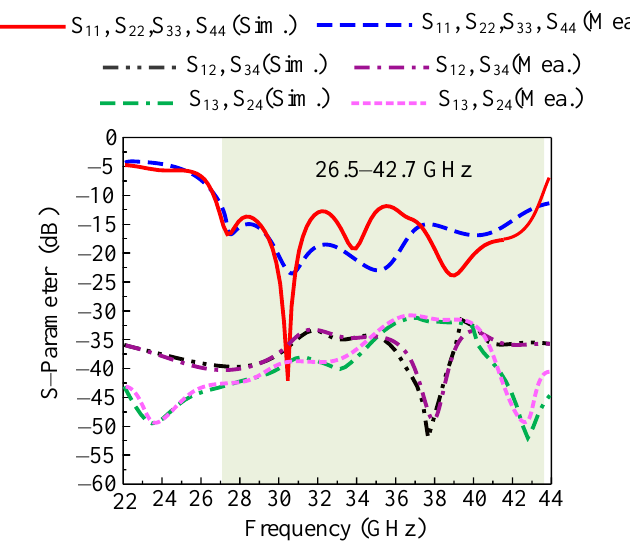
Figure 11. Comparison among S - parameters of MIMO antenna.